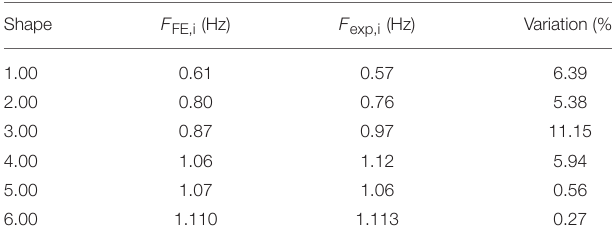
TABLE 3 | Comparison between experimental and numerical frequencies.